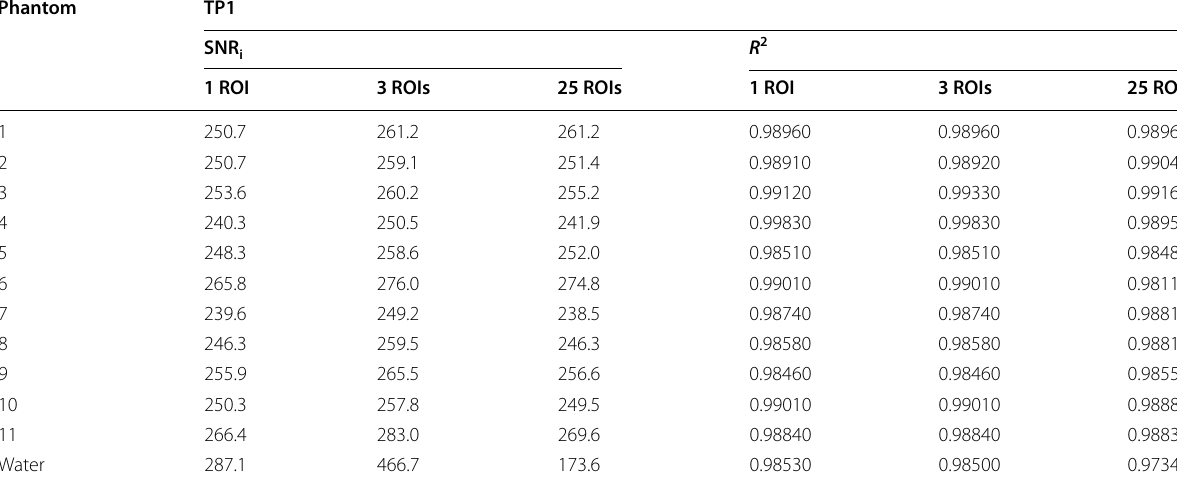
and R 2 values of agar gel and water phantoms for T2 curves at TP1 i